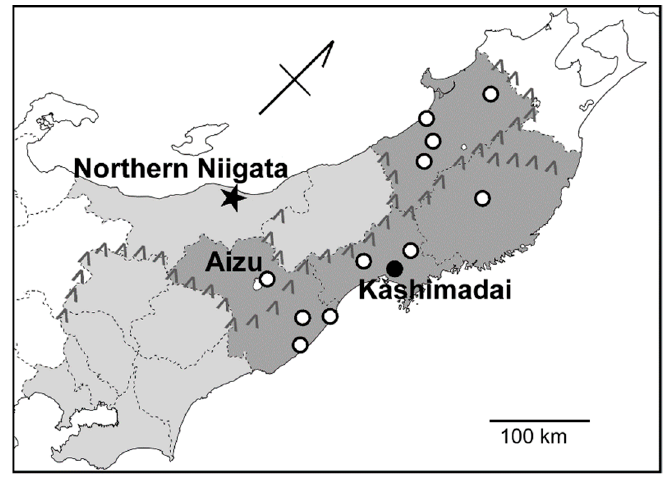
Figure 1. Map of the northern part of Honshu Island, Japan, showing collecting localities for Acheilignathus typus in the present (star) and previous [13] studies. The solid circle indicates a pond in Kashimadai with haplotypes identical to those from northern Niigata. Other known localities are indicated by open circles. Mountain ranges dividing watersheds are indicated by Λ . Dark gray areas contain present-day known localities, whereas areas in light gray indicate past distribution ranges.